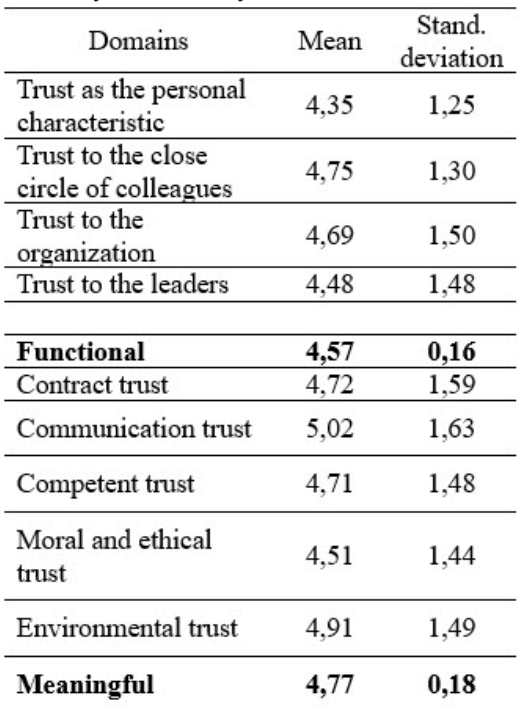
Table 2. Results of trust measure in the university